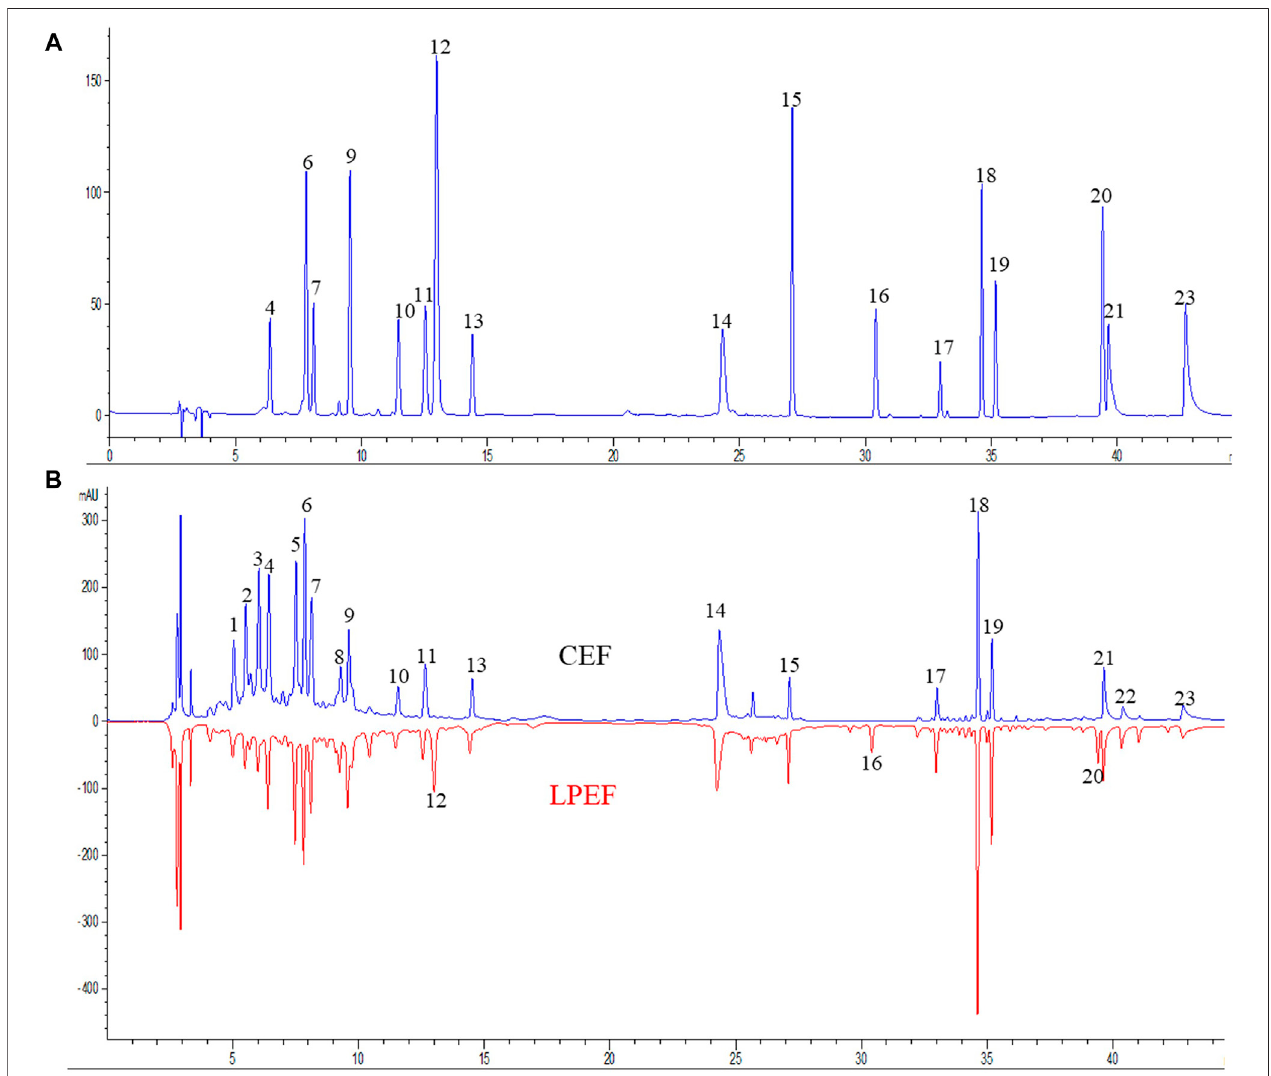
FIGURE 2 | Typical UHPLC chromatograms [ (A) chromatogram of 17 mixed standards, (B) fi ngerprints of CEF and LPEF]. Identi fi cation of peaks is shown in Table 3 .